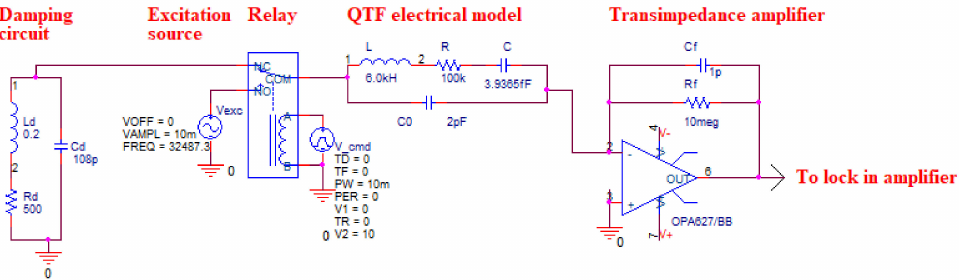
Figure 3. Schematic of the electronics circuit on OrCAD PSPICE including the damping circuit, the excitation source, the switching relay, the QTF and the transimpedance amplifier